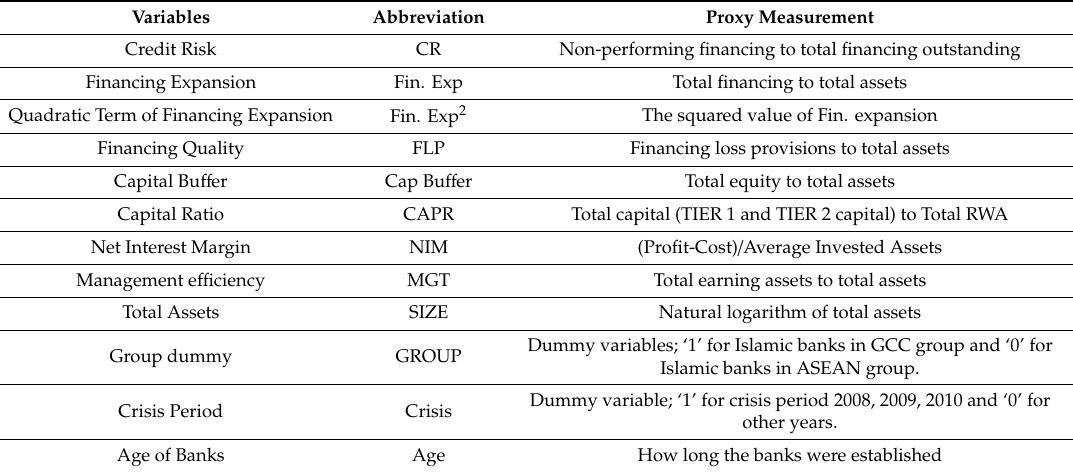
Table 2. Empirical Model Variables and